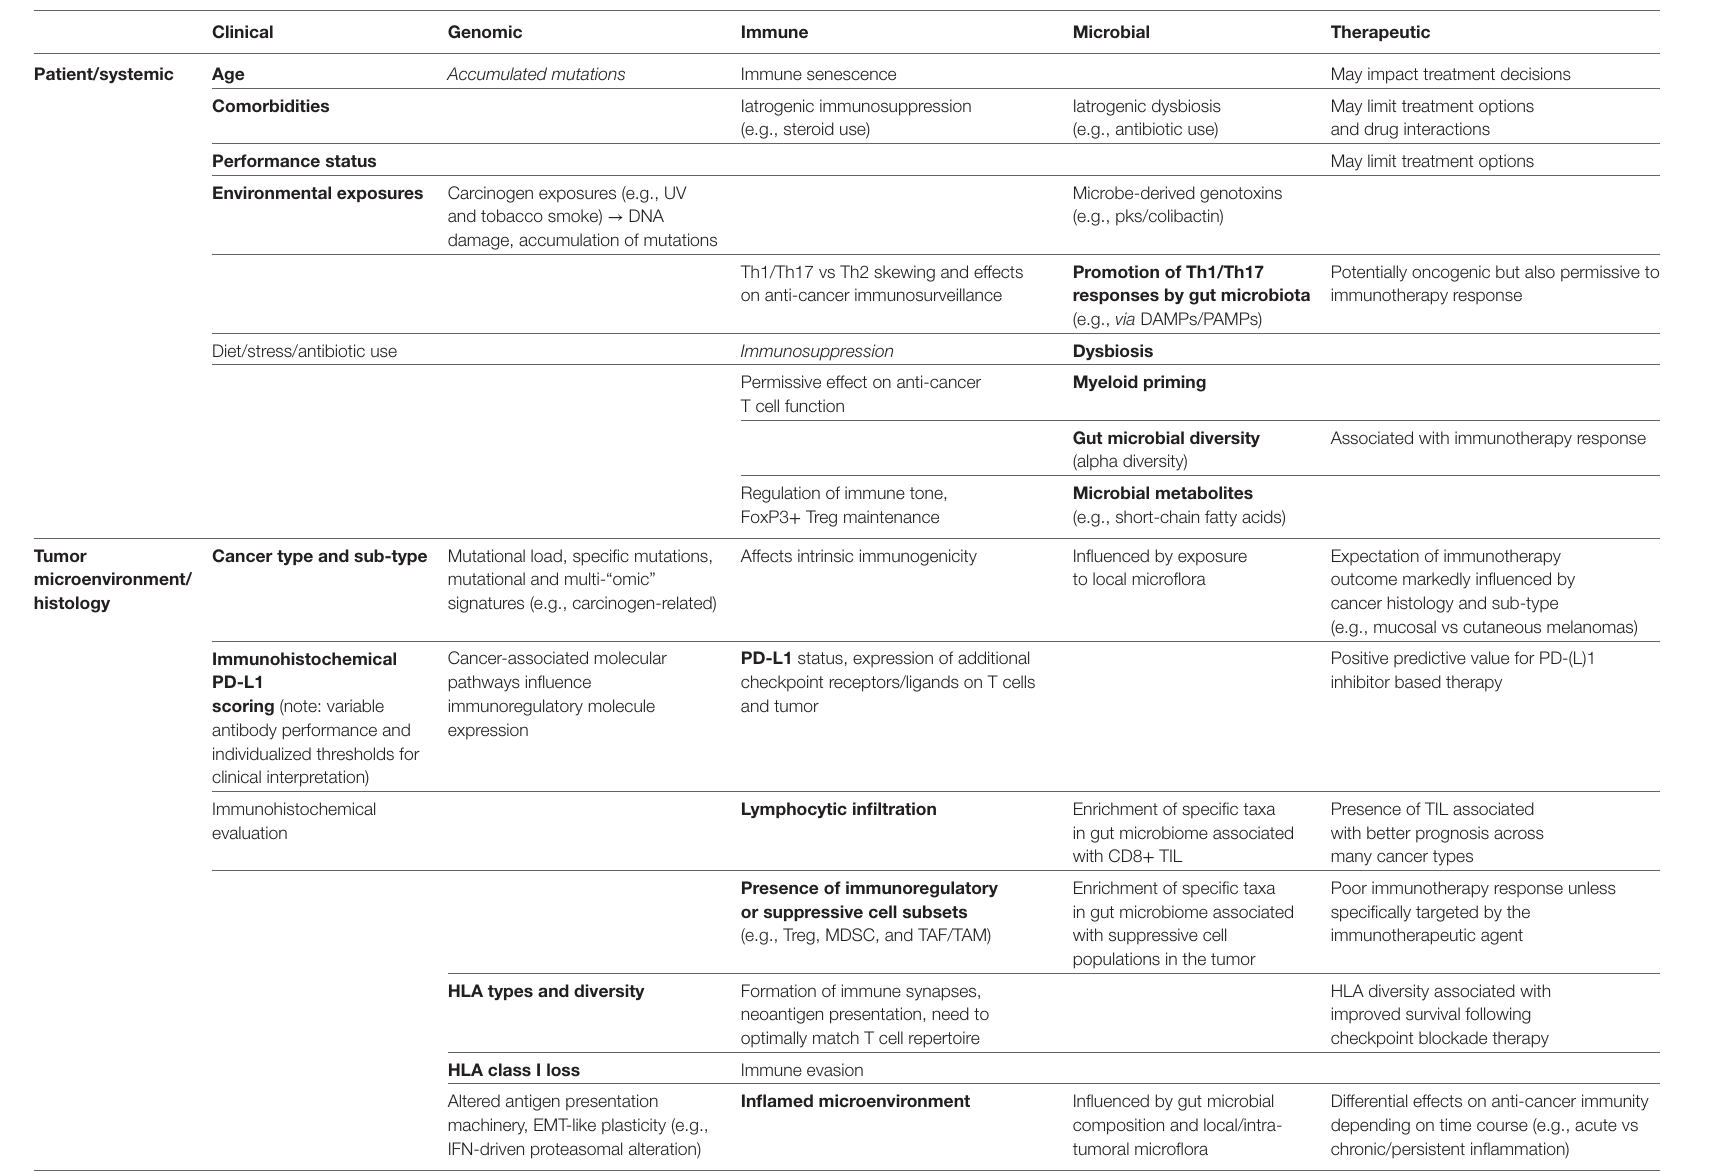
TABLe 1 | Inter-relationships between clinical, genomic, immune, and microbial factors drawn from the patient (systemic), tumor microenvironment (histology), and disease-level domains, with associated influence on immunotherapeutic